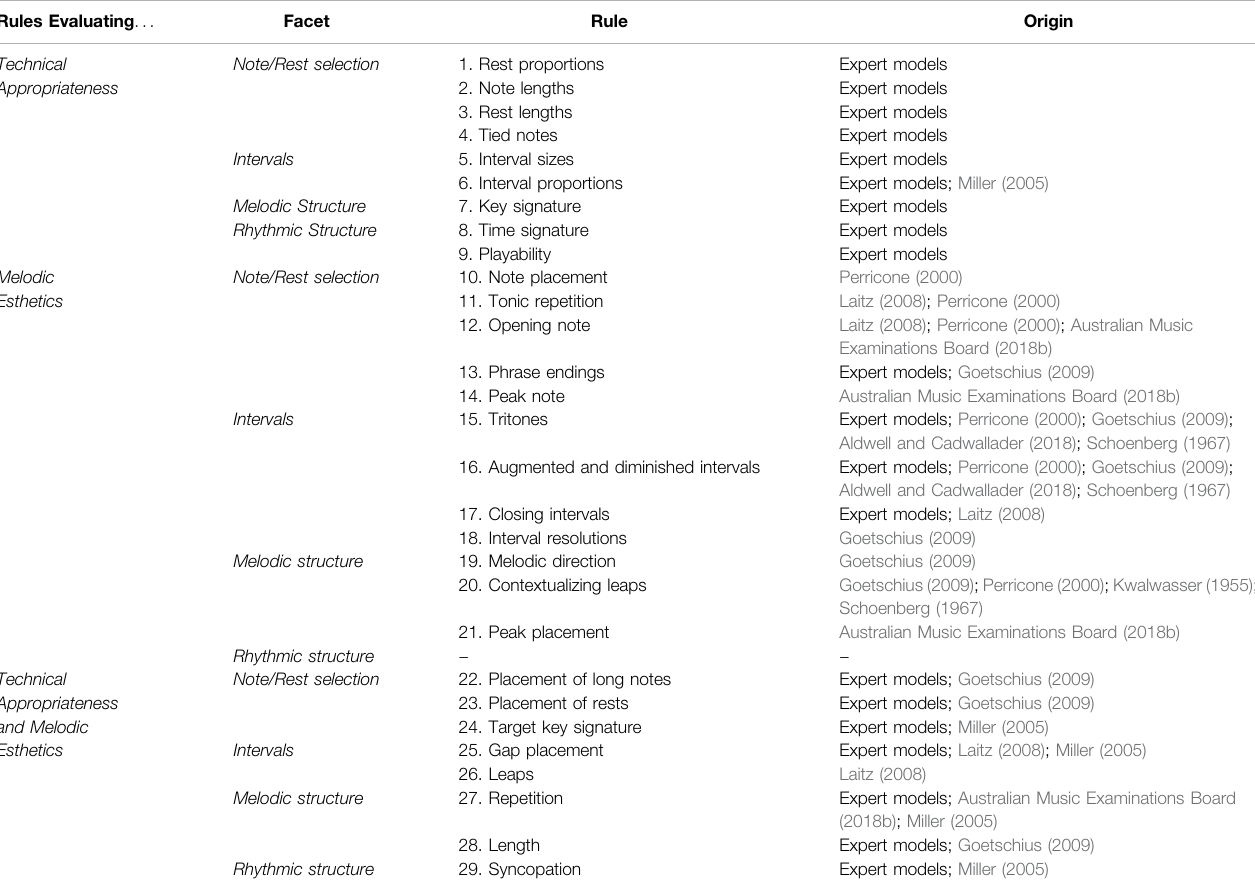
TABLE 5 | The origin of each rule in the ruleset for evaluating algorithmically generated sight reading exercises. Note that there are no rules for evaluating just the melodic esthetics of rhythmic structures, only technical appropriateness alone or technical appropriateness and melodic esthetics combined. Rules Evaluating